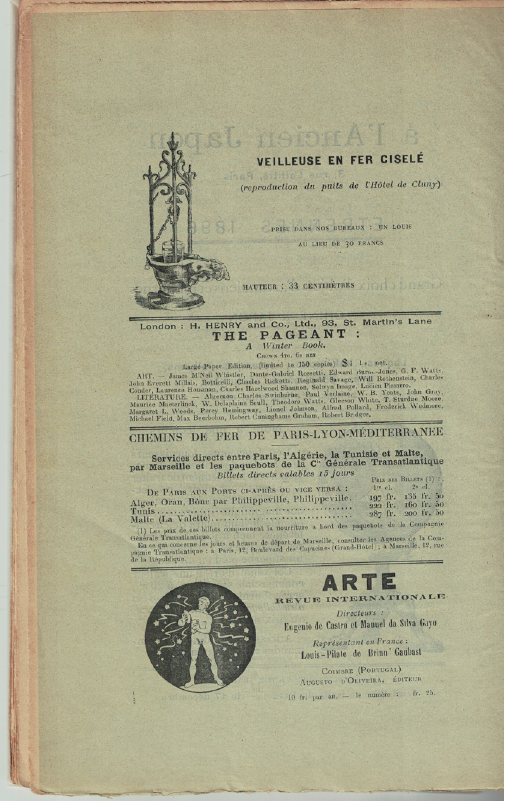
Fig. 3 La Revue blanche , 9.61 (15 December 1895), between p. 576 and the end of the